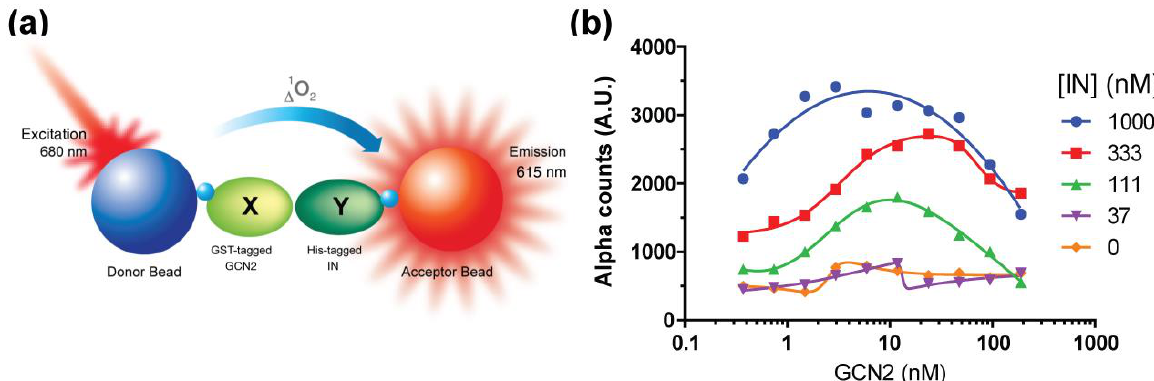
Figure 1. ( a ) Protein–protein interaction assay principle using AlphaLISA. ( b ) Cross-titration experiment.